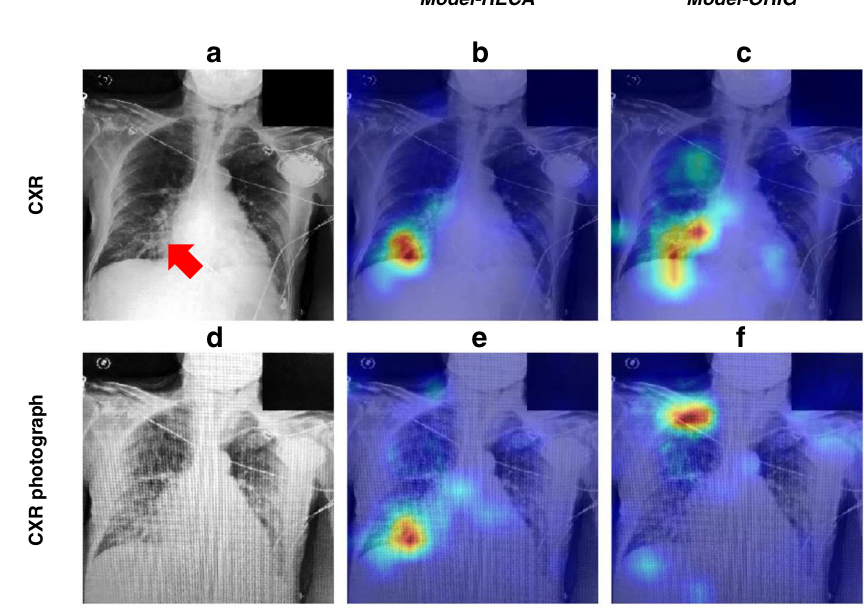
Fig. 5 An example of the visualization of the diagnostic focus of two models. a An example CXR is diagnosed as consolidation from the radiology report. The red arrow indicates the abnormal location. ( b) and ( c ) show the diagnostic focus of the recalibrated model ( Model-RECA ) and the uncalibrated model ( Model-ORIG ) tested on the original CXR, respectively. ( e ) and ( f ) show the diagnostic focus of the Model-RECA and the Model-ORIG tested on the corresponding CXR photograph, respectively. The colors from blue to red map the strengths of the contribution of each image location from low to high for predicting